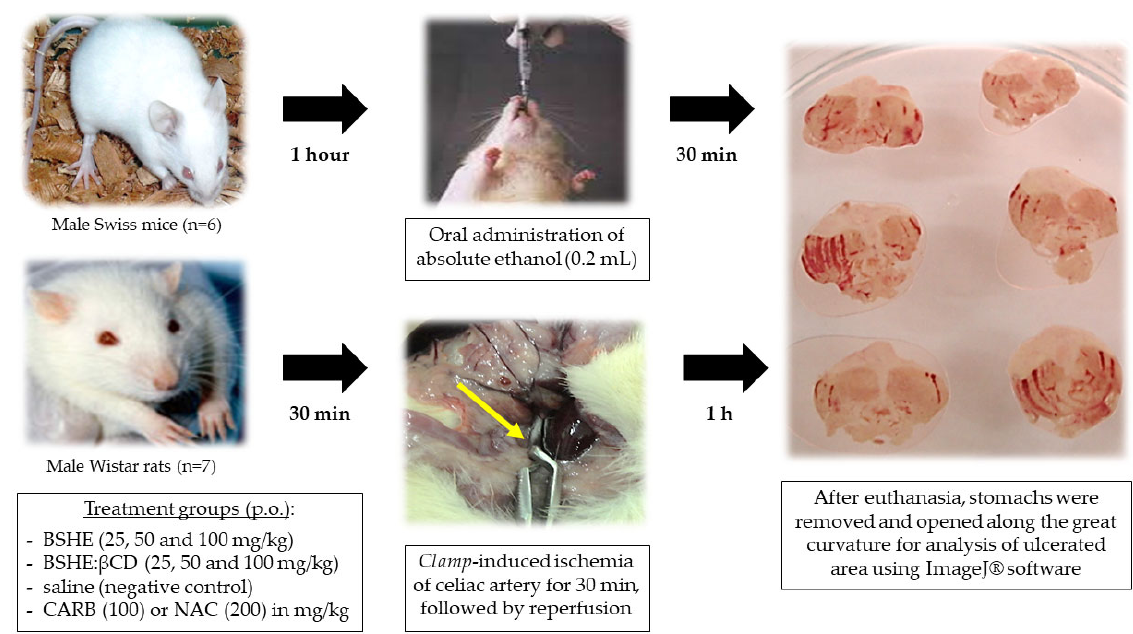
Figure 2. General scheme of ethanol and ischemia/reperfusion ‐ induced gastric ulcers in rodents. Legend: CARB = carbenoxolone; NAC = N ‐ acetylcysteine.